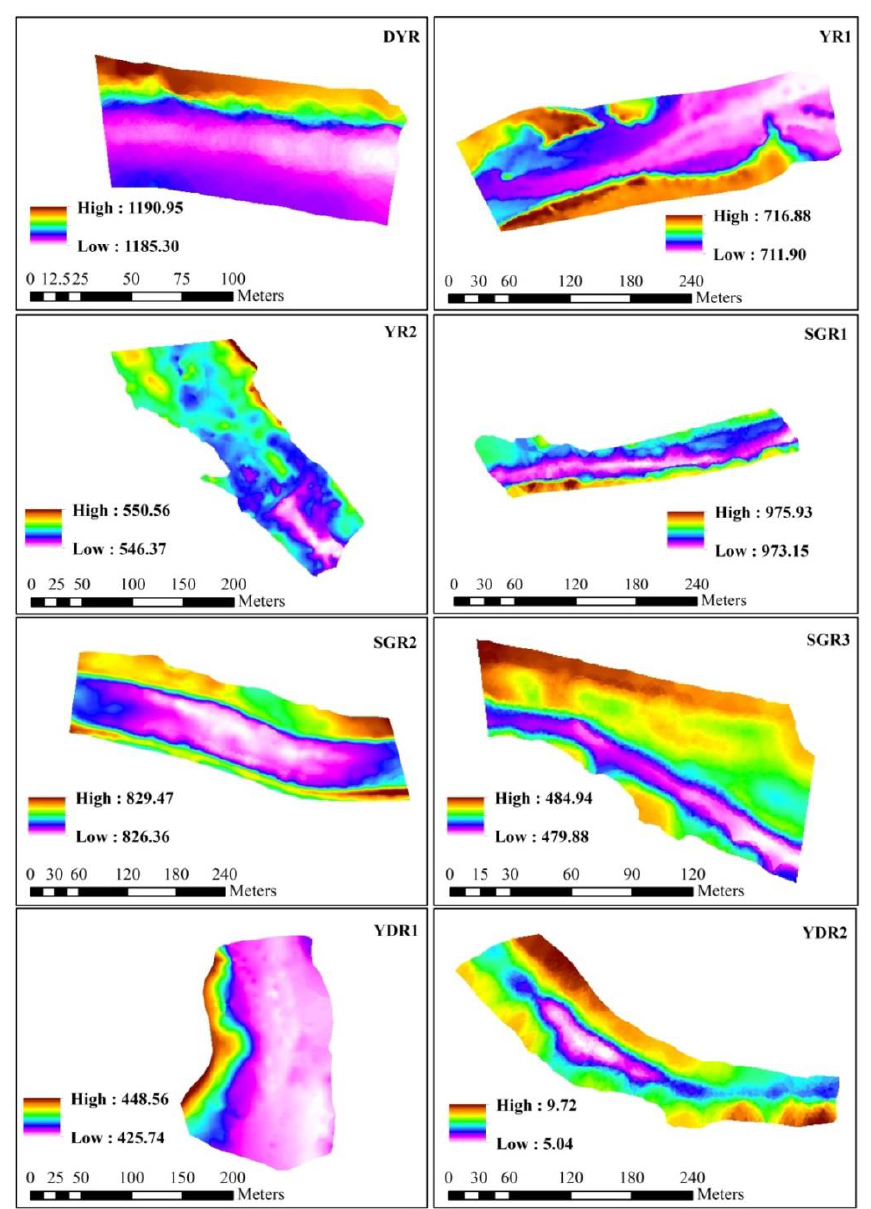
Figure 5. Riparian (Digital Terrain Model) DTM of the eight selected reaches.